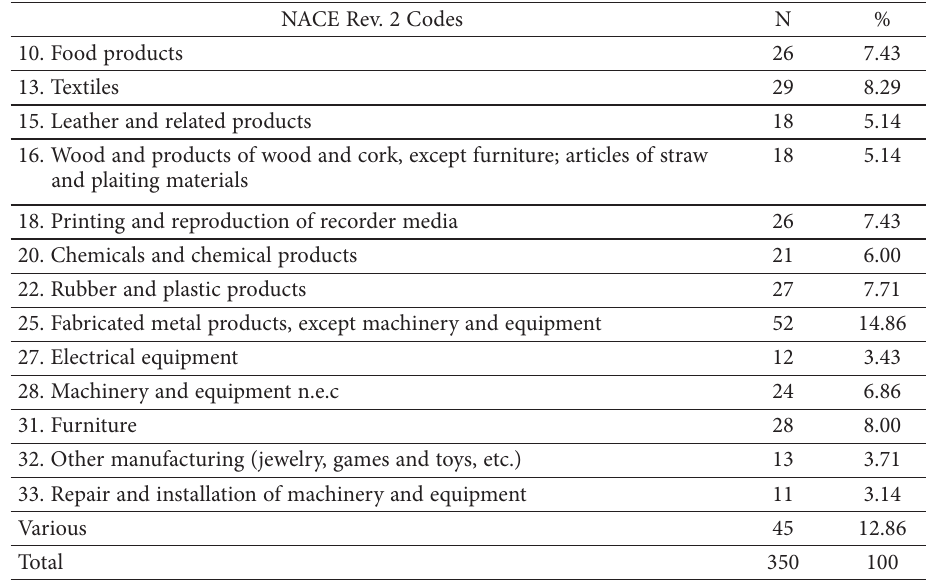
Table 2. Sector distribution of the firms in the sample NACE Rev. 2 Codes